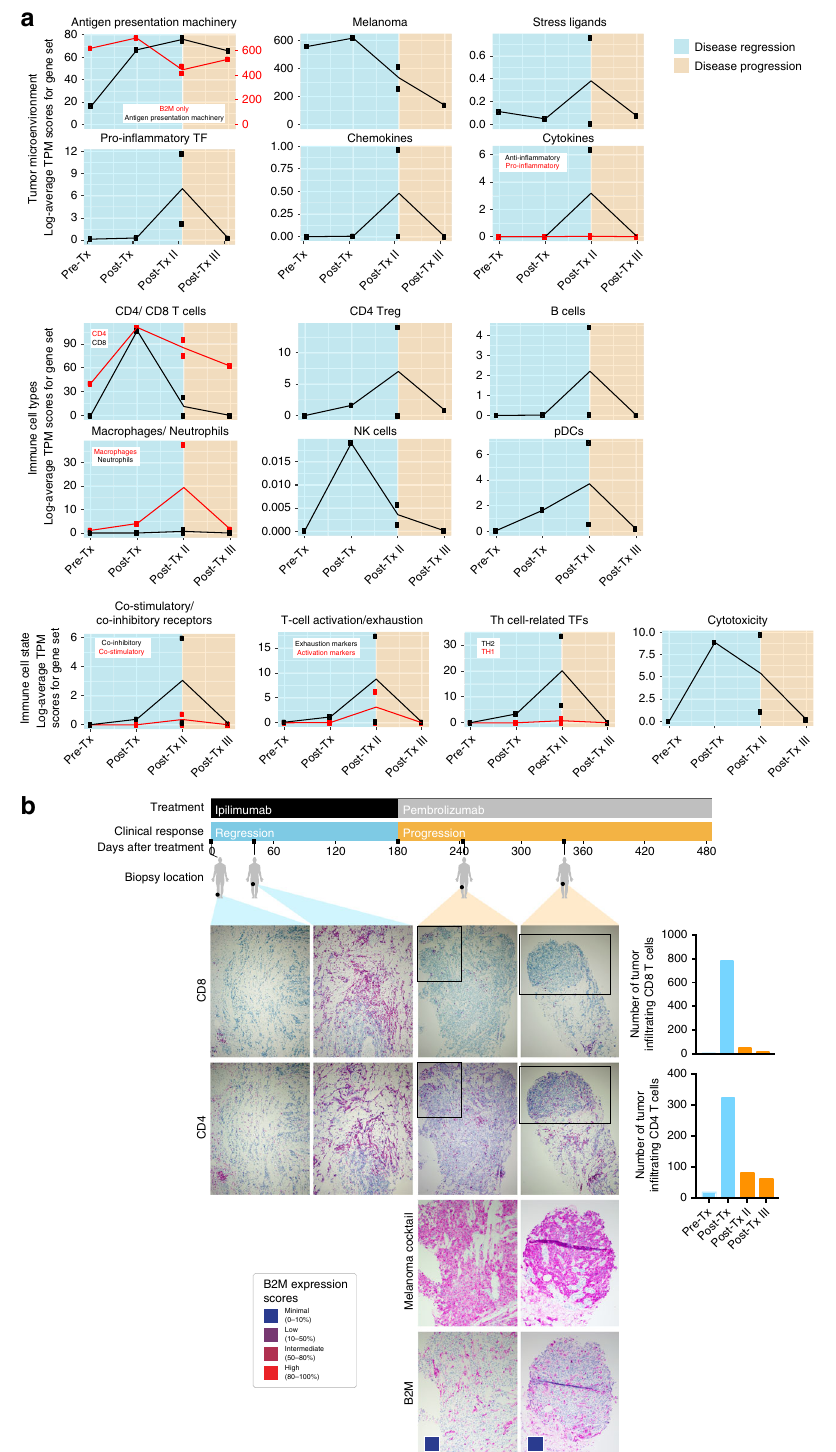
Fig. 2 Dissecting the tumor microenvironment during disease regression and progression. a Expression scores of genes related to the tumor microenvironment, immune cell types, or immune cell states. Expression scores were calculated as the geometric mean of TPM values of genes in Supplementary Data 3. Blue backgrounds indicate biopsies taken during disease regression, and orange backgrounds indicate biopsies taken during disease progression. b Samples for each time point from Pat208 were stained with speci fi c antibodies against CD8 or CD4 and were quanti fi ed using the cell counter function in Fiji (described in “ Methods ” section). Boxes areas in the upper panels (CD4 and CD8, original magni fi cation ×100) are shown at higher magni fi cation (×200) in the lower panels (melanoma cocktail and B2M). Colored boxes indicate B2M expression scores: B2M scoring was estimated by using four different levels of expression in the tumor fraction: minimal, 0 – 10%; low, 10 – 50%; intermediate, 50 – 80%; and high, 80 – 100%, B2M expression in the tumor fraction. A timeline of treatment, clinical response, and biopsy locations is shown at the